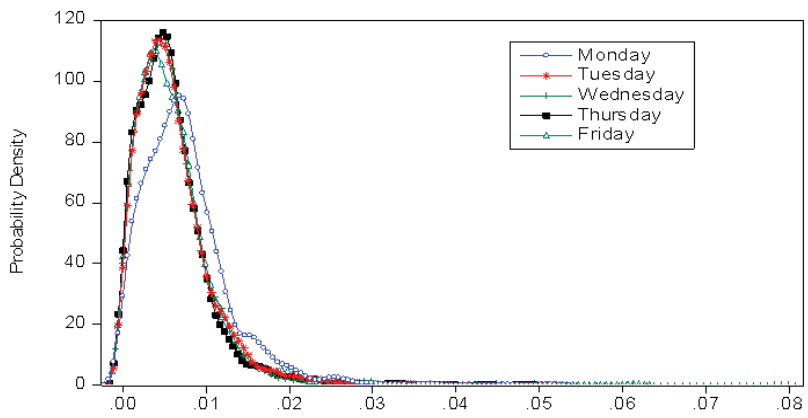
Fig. 9. Probability distributions of gold volatility from Monday to Friday in New